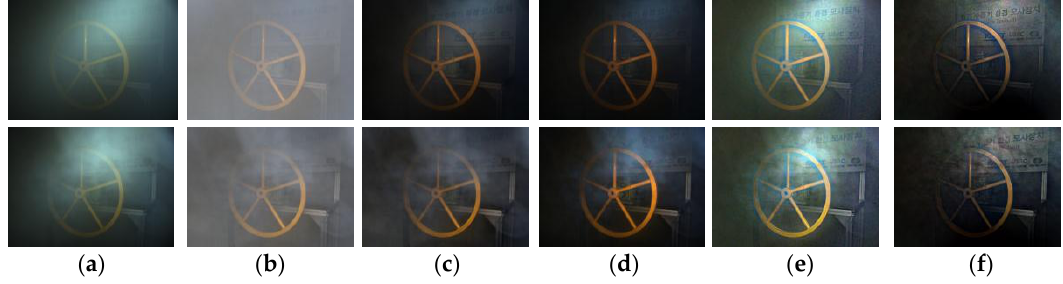
Figure 4. Descattering and defogging result. ( a ) Corrupted images; ( b ) Light compensated image; ( c ) Our descattered result; ( d ) Our defogged result; ( e ) Nighttime dehazing from Zhang et al. [35]; ( f ) Nighttime dehazing from Li et al. [36].